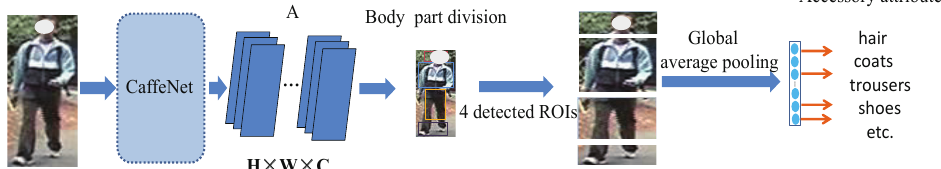
Figure 3. The accessory attribute network divides the convolutional feature map A into four ROIs (regions of interests) using peak activation detection and pooling as the reference [9]. Features from the four ROIs are further used for person accessory descriptor extraction.